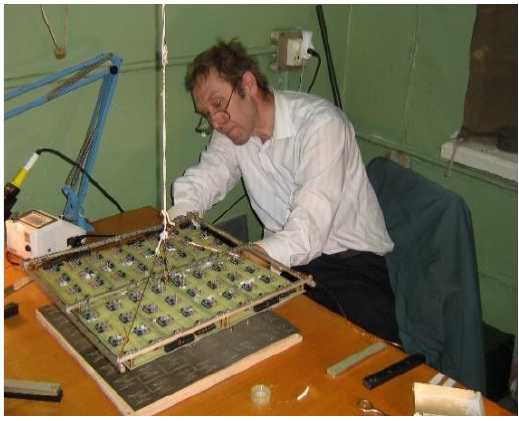
Figure 3. 16 × 16 element planar antenna array designed at JSC Jupiter-Z.